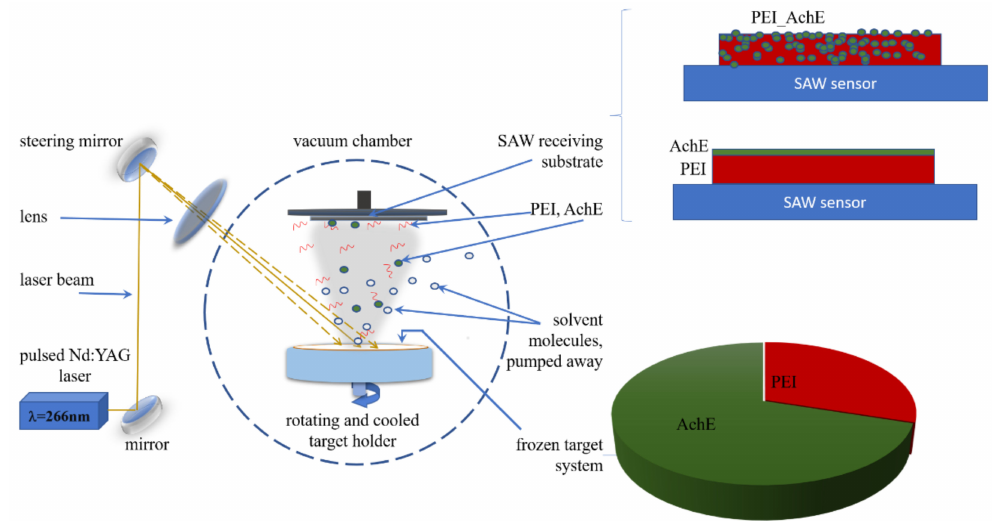
Figure 1. Matrix-assisted pulsed laser evaporation (MAPLE) setup and target system used for obtaining hybrid polyethylenimine (PEI)-acetylcholinesterase (AchE) coatings and layered PEI/AchE thin